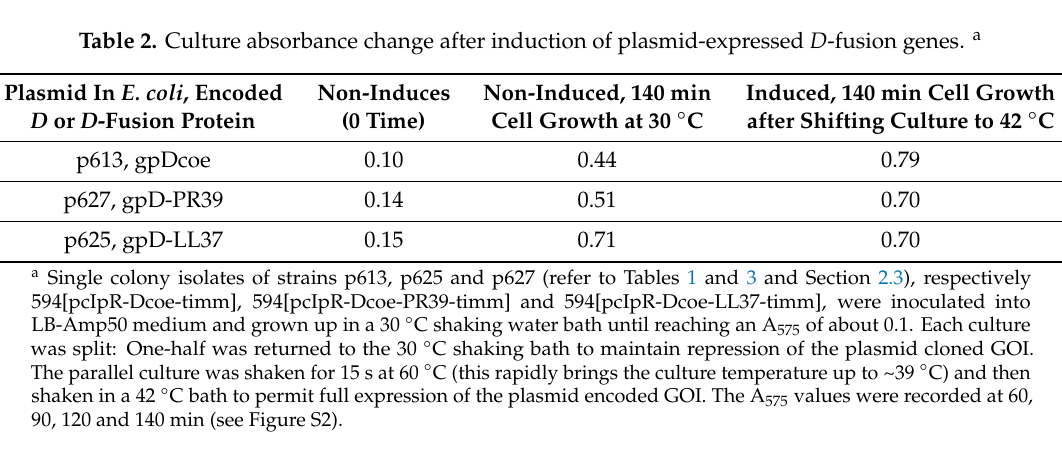
Table 2. Culture absorbance change after induction of plasmid-expressed D -fusion genes. a